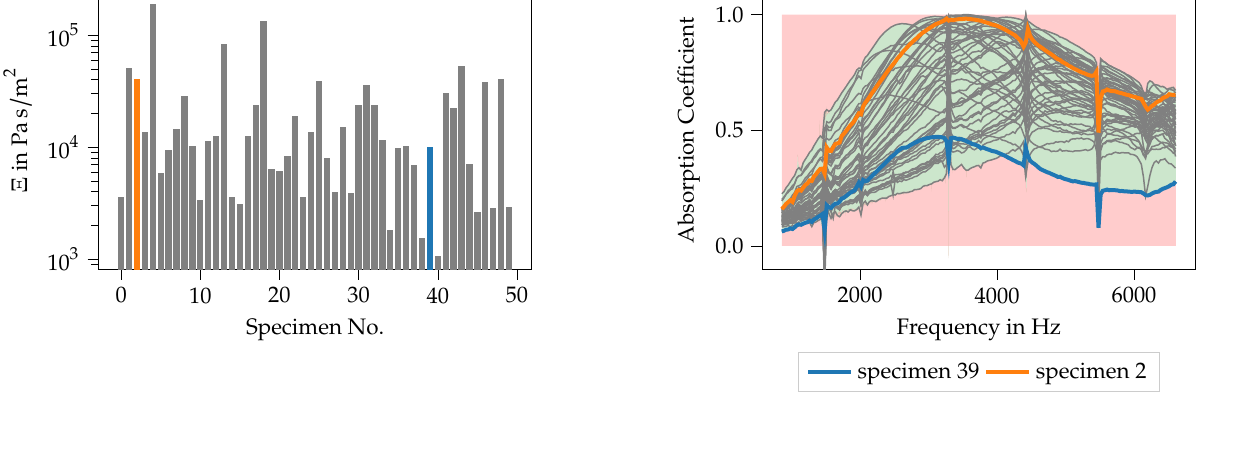
( a ) Overview of all flow resistivity measurements for the specimen ( b ) Overview of all conducted absorption coefficient measure- population of 50 specimens. It can be seen that specimen 2 and 39, ments for the specimen population of 50 specimens. The green which represent the highest and lowest mean absorption coefficient and red areas indicate data ranges for which specimens are/are do not as well represent extreme values for the flow resistivity. not already available. Figure 7. Measured data (flow resistivity and absorption coefficient) of all 50 investigated specimens. The specimens 2 and 39 are marked in orange and blue, respectively, and represent those specimens with the highest and lowest mean absorption coefficient in the frequency range.